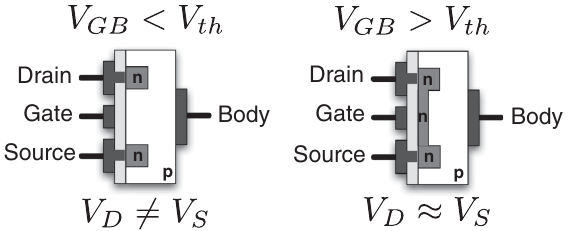
FIG. 1. Graphical depiction of the operation of a classical transistor. In a classical transistor such as the n -channel MOSFET shown, the application of a voltage at the gate input transforms the semiconductor in a manner such that a channel opens between the drain and source. Note that this transition is switched by the application of an electric field. Traditionally, we think of this action as a switch, but there is another possible interpretation. In particular, the application of the applied electric field has the effect of copying thevoltage at the source to the drain, which we can interpret as an identity logical gate (a logical gate that takes in a single bit and outputs this bit unchanged) on the classical information encoded as a voltage. Quantum information cannot be copied [14], so if we are to imagine a suitable analogy of thetransistor inthe quantumworld,thequantuminformation must move from the source to the drain. This result is what our proposed adiabatic quantum transistors would achieve.